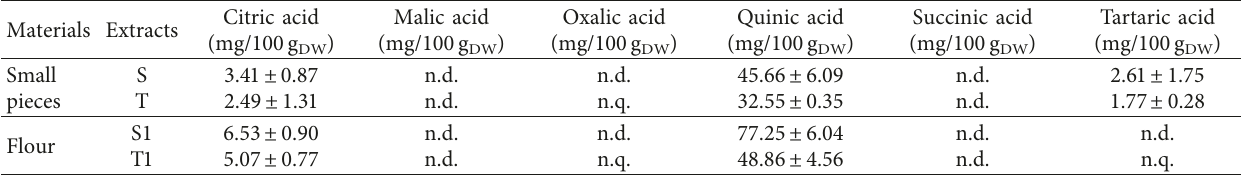
Table 4: Organic acid composition of breadfruit